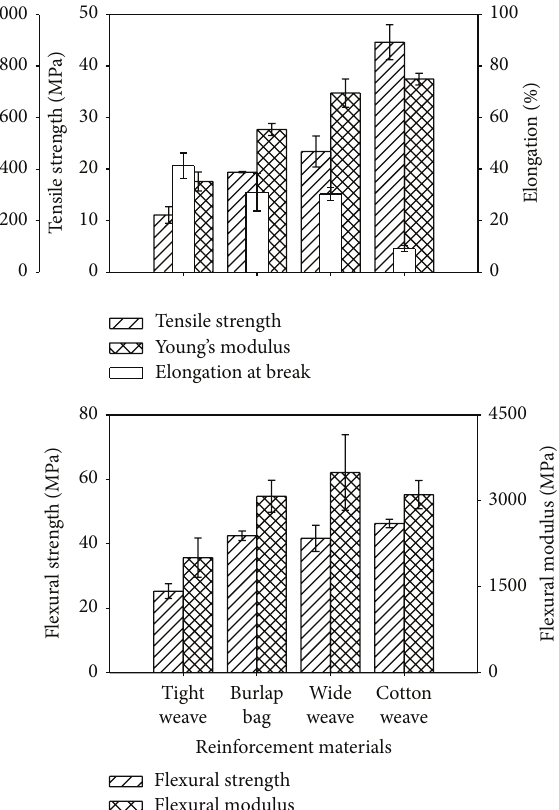
Figure4:MechanicalpropertiesofLCemployingvariousreinforce- ment weave materials. LCs were prepared using the MPM method with a reaction incubation temperature of 80 ∘ C followed by 4hrs of water